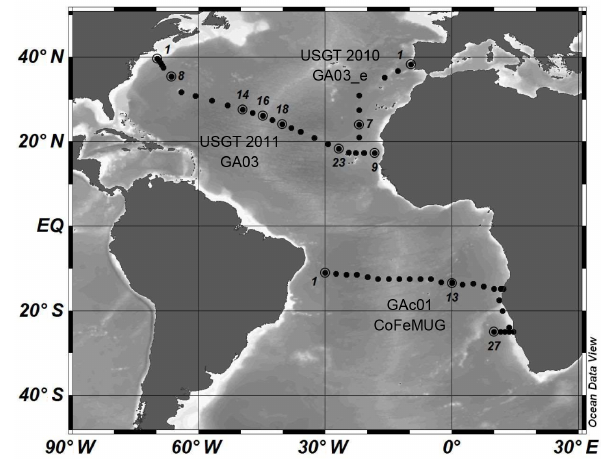
Figure 1. Expedition tracks of the US North Atlantic GEOTRACES zonal transect (GA03/3_e; USGT10; cruise number KN199-4, stations 1–12; and USGT11, KN199-5b stations 1–24) and the GEOTRACES-compliant CoFeMUG South Atlantic Expedition (GAc01; KN192-5, 2007). Stations were numbered sequentially from the beginning of each expedition (Portugal for GA03_e; Woods Hole for GA03, USA; and Natal, Brazil, for GAc01, respec- tively) with station numbers shown for selected stations. The North Atlantic stations are described in later figures by the year and station number (e.g., 11-01 for the 2011